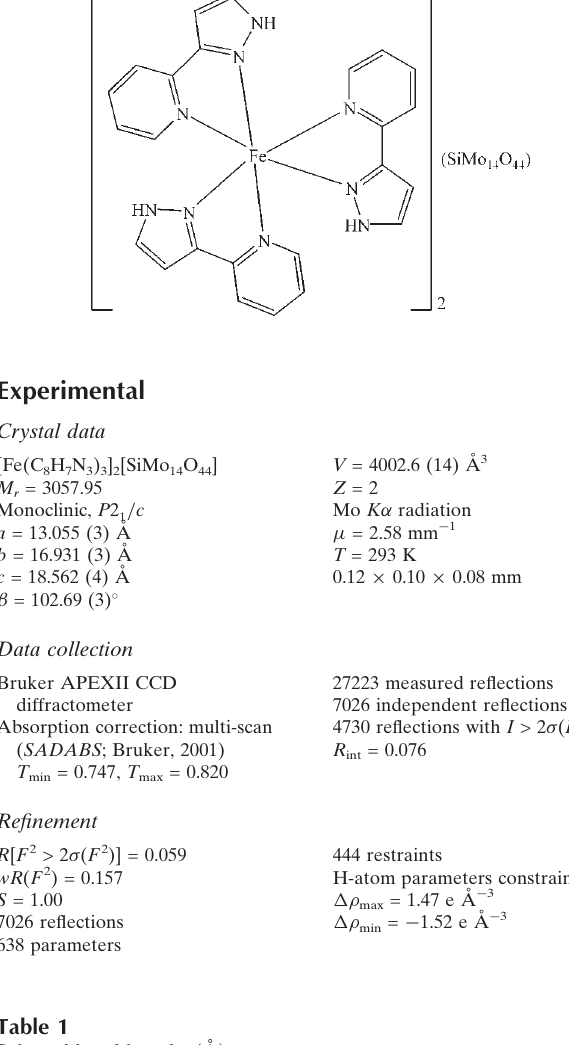
Selected bond lengths (A˚ ).